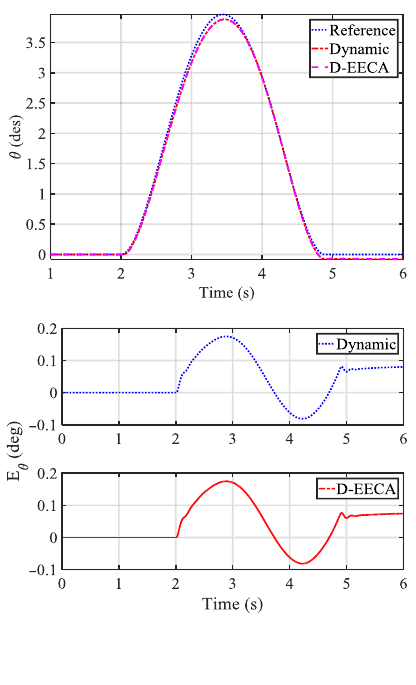
Figure 11 The yaw rate of A-IWMs EV and tracking errors